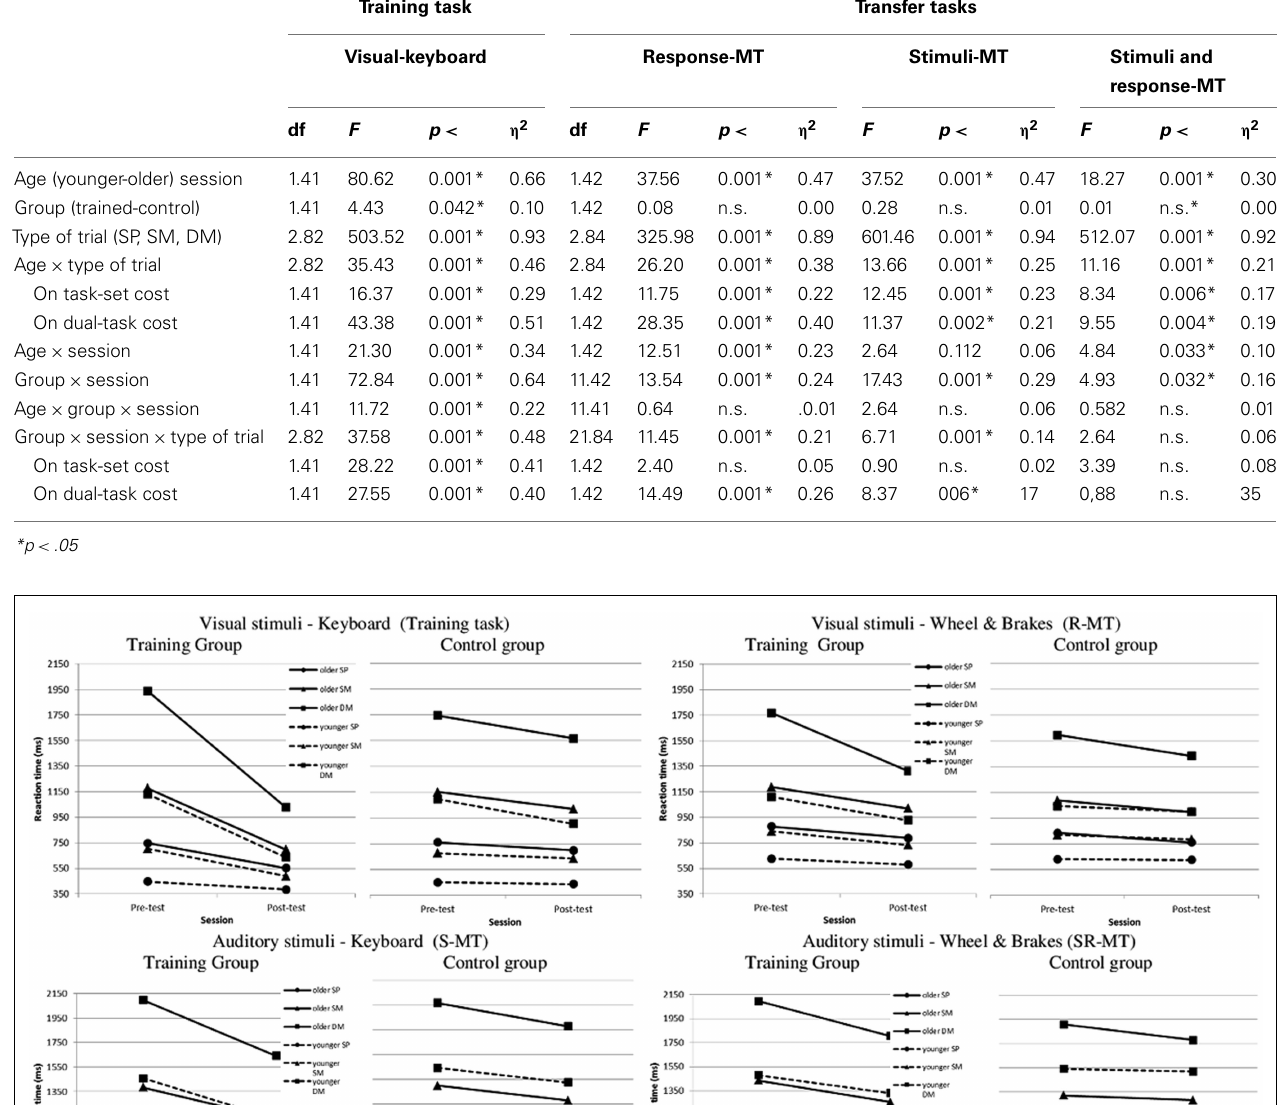
transfer (R-MT) dual-task condition (second panel), the stimulus modality transfer dual-task condition (S-MT) (third panel), and the stimuli–response modality transfer (RS-MT) dual-task condition (last panel).